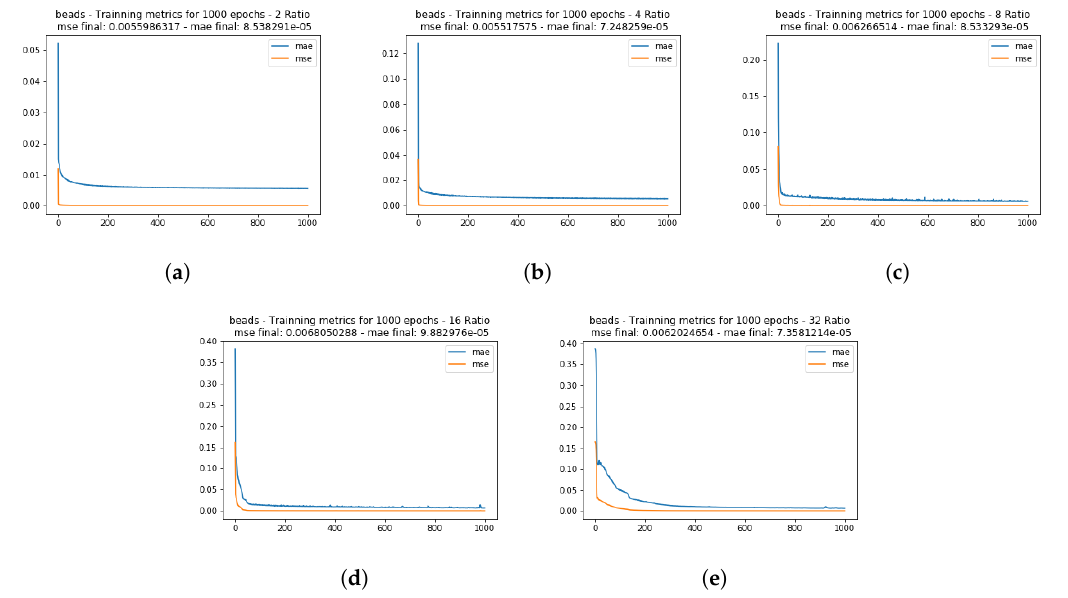
Figure 5. Mean squared error (MSE) and mean absolute error (MAE) training metrics for the CAVE dataset images, for the ratios of 2 ( a ), 4 ( b ), 8 ( c ), 16 ( d ), and 32 ( e ), with resolutions of 256 × 256, 128 × 128, 64 × 64, 32 × 32, and 16 × 16 pixels, respectively. Similar results were found for the other images tested.